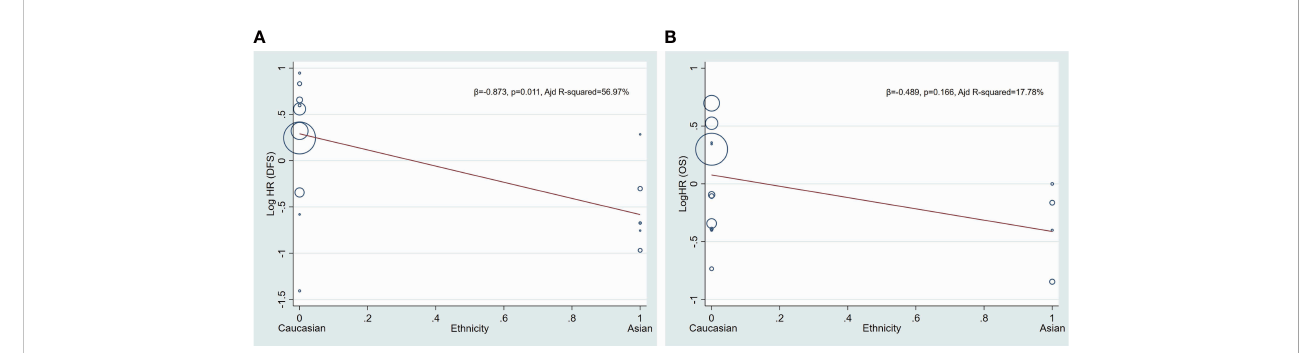
FIGURE 3 Univariate meta − regression analysis. Log HR of DFS and OS according patient source (ethnicity). A circle represents a study, and the diameter of circle represents sample capacity. Various ethnicity (patient source) descents were classi fi ed as Caucasian and Asian. HR, hazard ratio; DFS, disease-free survival; OS, overall survival.